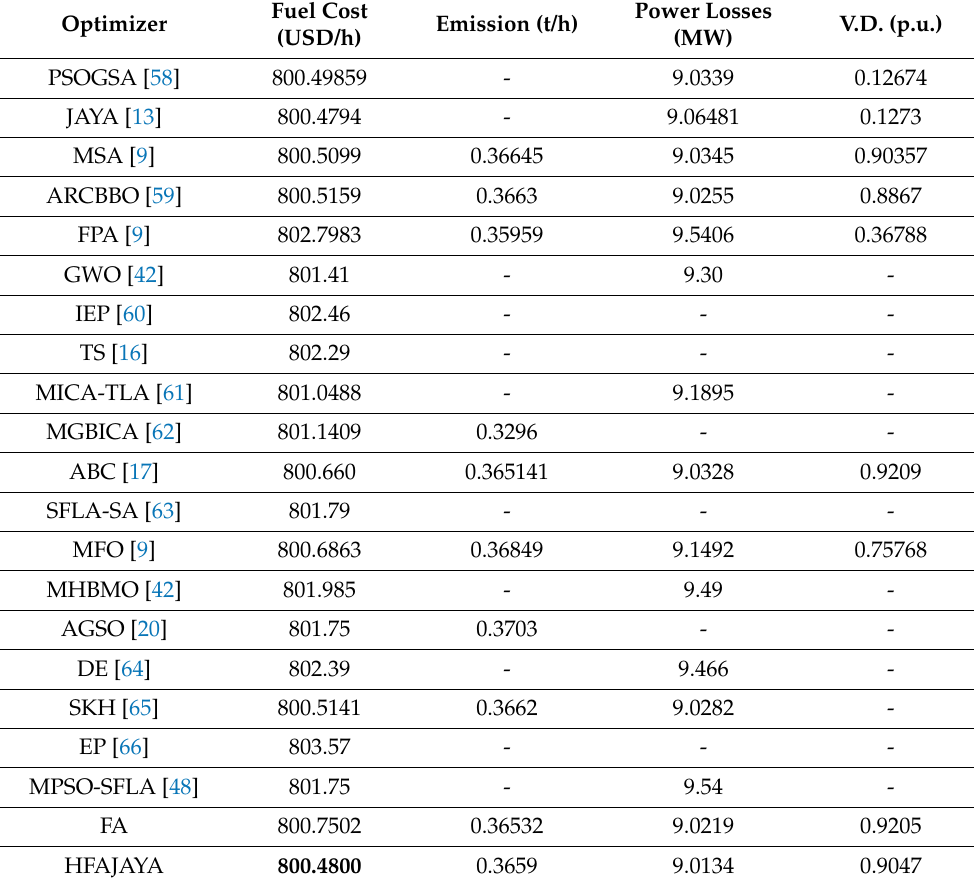
Table 3. The obtained optimal results in the current works for Case